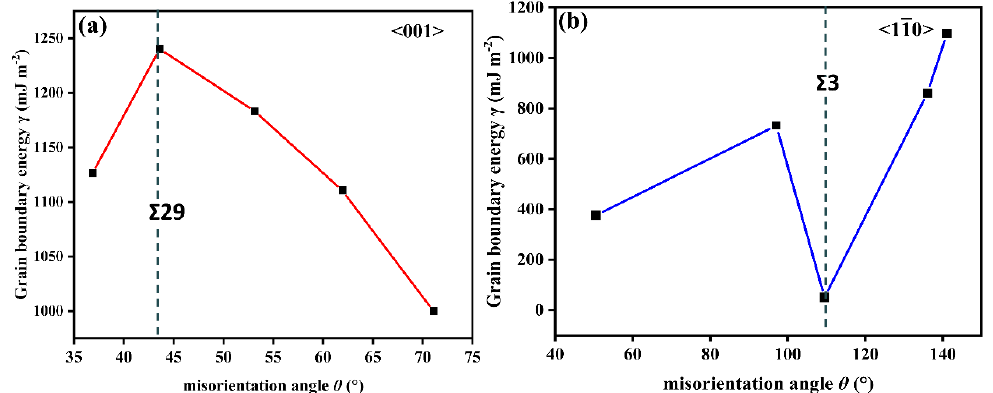
Figure 3. GB energy as a function of misorientation angle for ( a ) < 001 > and ( b ) < 11(cid:3364)0 > STGBs. The GB energy for Ni is represented by the black square. The vertical dashed line indicates the GB of interest.